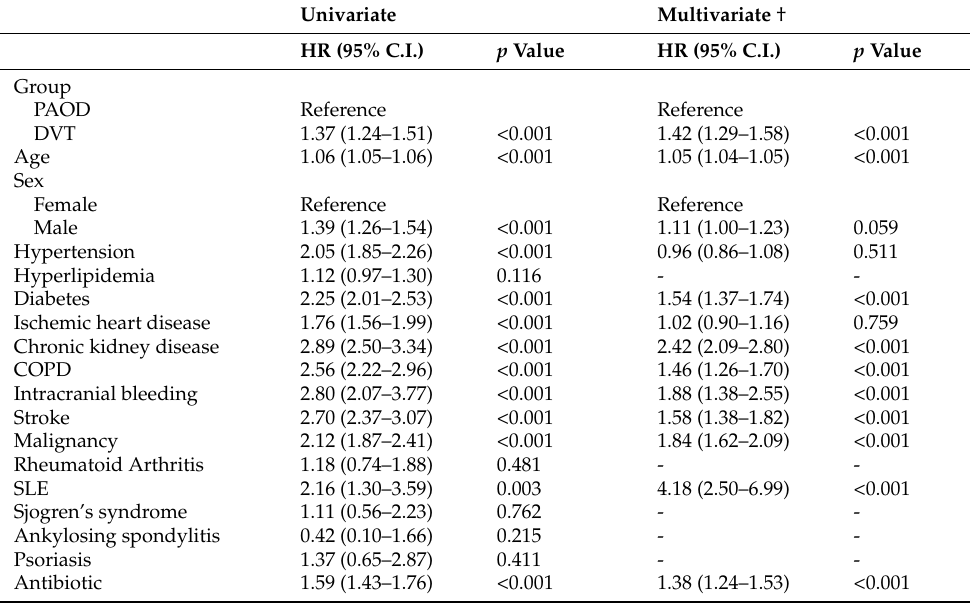
Table 3. Cox proportional hazard model analysis for risk of sepsis.